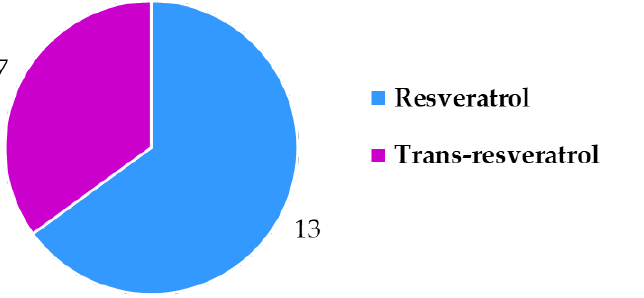
Figure 12. Resveratrol vs. trans -resveratrol declarations on food supplement labels.